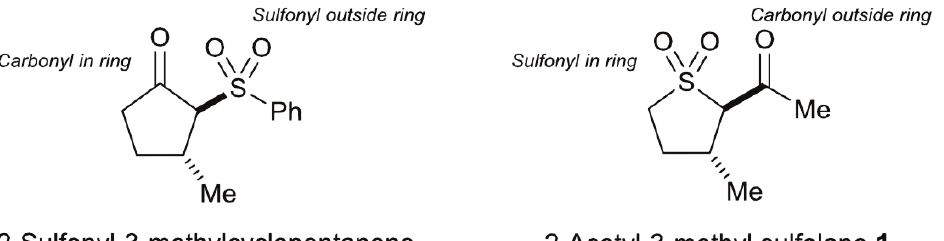
Figure 1. 2-Sulfonyl-3-methylcyclopentanone and 2-acetyl-3-methyl sulfolane 1